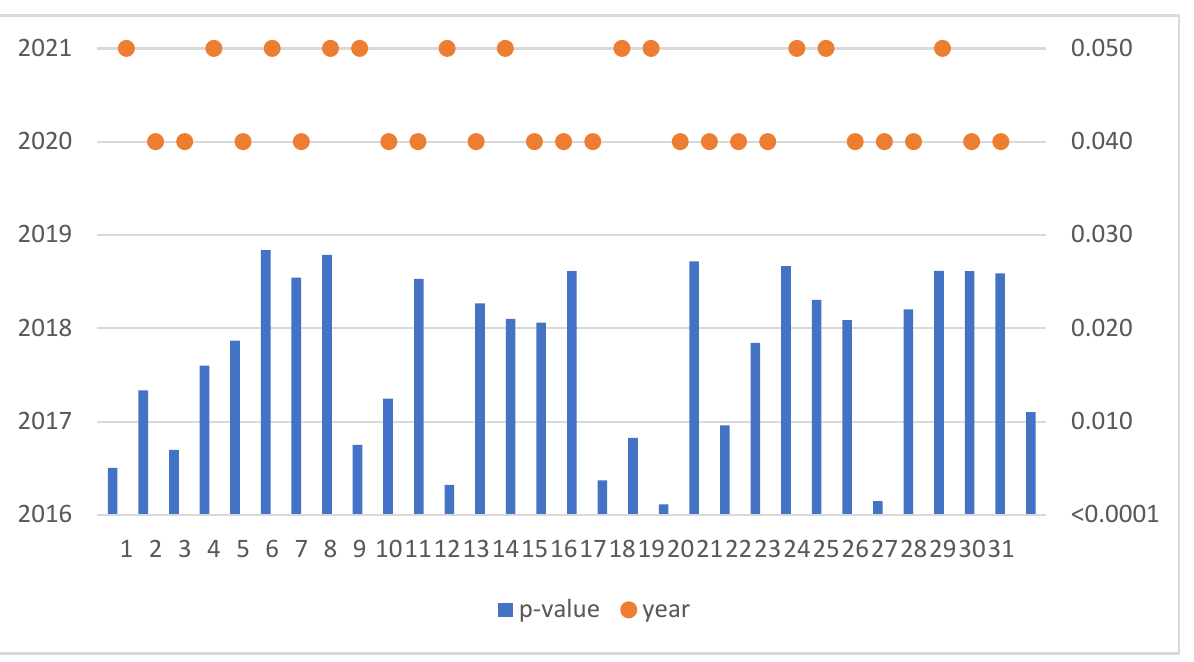
Figure 10. Heterogeneity in Czechia.